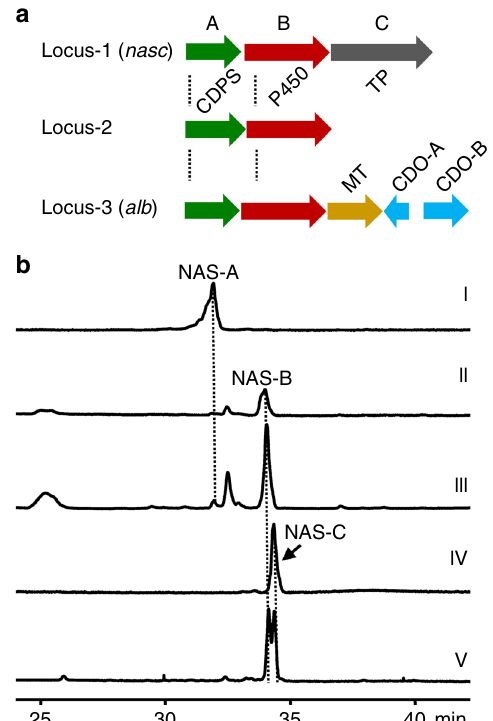
Fig. 2 Gene clusters and correlation of locus-1 to NAS-C biosynthesis. a Biosynthetic gene clusters with CDPS and P450 in CMB-MQ030. Locus-1 and 2 are resembling only except locus-1 contains an additional TP (transporter) gene; locus-3 containing MT (methyltransferase), CDO-A (cyclodipeptide oxidase A), and CDO-B (cyclodipeptide oxidase B) is homologous to alb biosynthetic gene cluster. b HPLC analysis the production of NAS-C in CMB-MQ030 and locus-1 expression S. albus . (I) Standard NAS-A, (II) standard NAS-B, (III) CMB-MQ030, (IV) mWHU2475 ( S. albus containing locus-1), and (V) standard NAS-C spiked with standard NAS-B from the co-injection of standard NAS-C and